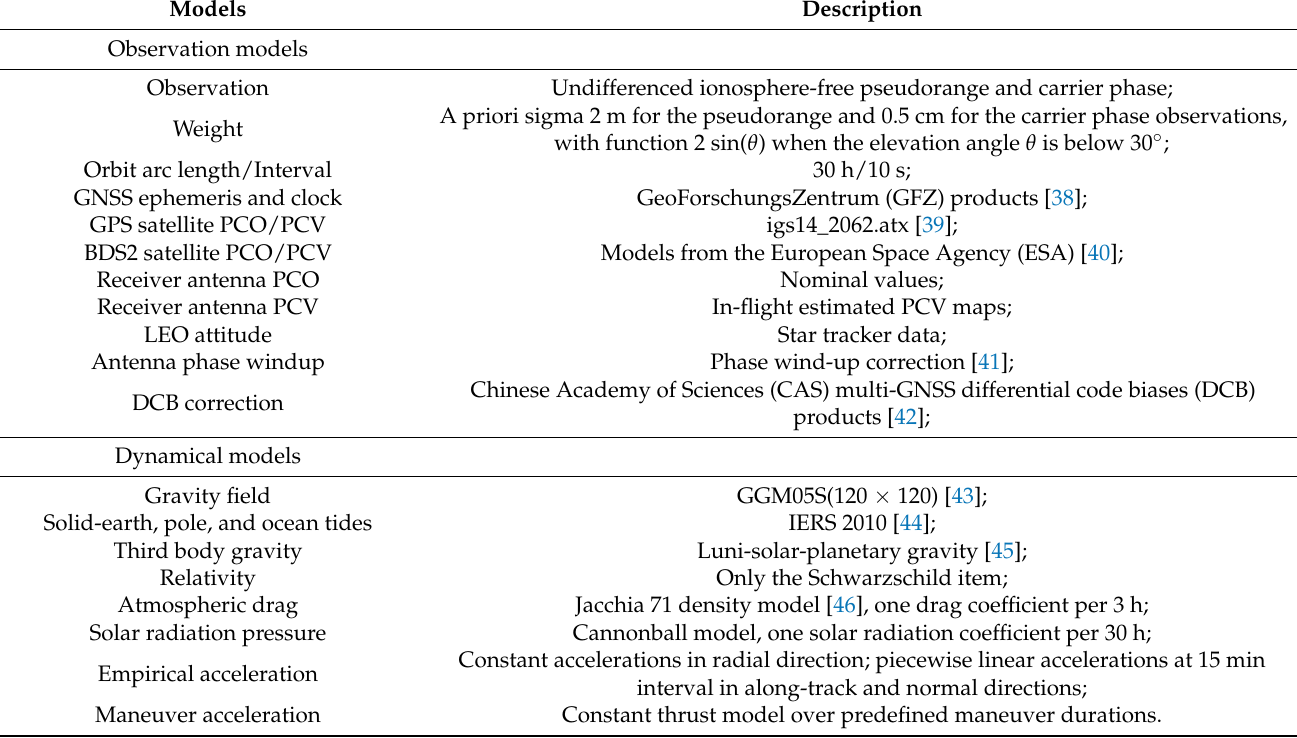
Table 1. Processing strategy for the POD of